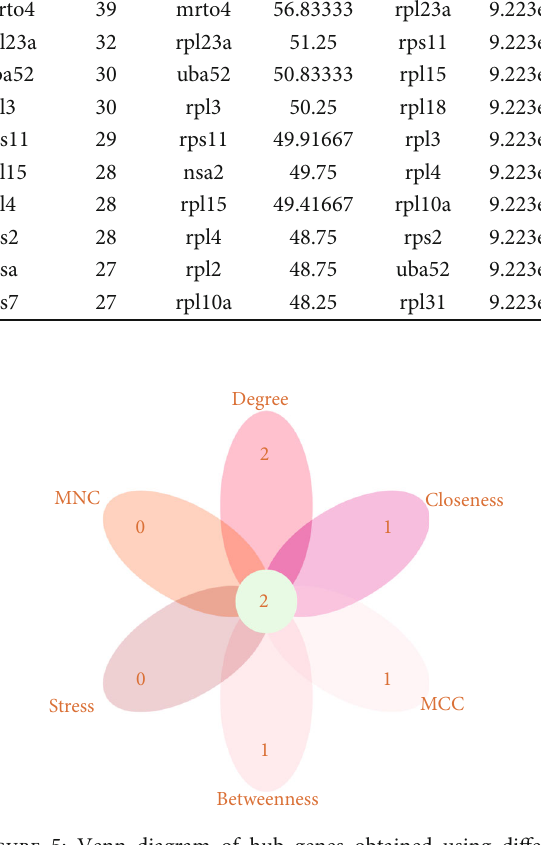
Figure 5: Venn diagram of hub genes obtained using di ff erent algorithms. The number marked in the center represents the number of hub genes obtained by the intersection of the six